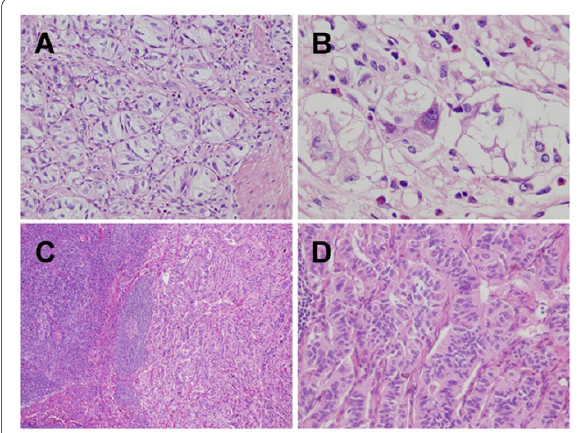
Figure 2 Photomicrographs showing different types of tumor cells . (A) Tumor cells of epithelioid cell type are usually nested which are encompassed by those of spindle-shaped cell type with alignment of a single cell layer (HE double stain, × 400). (B) Ganglion-like cells; third type of the tumor cell had a large and oval nucleus with conspic- uous nucleolus, as well as a polyhedral amphophilic cytoplasm (HE double stain, × 1000). (C and D) The metastasizing component of the tumor at the lymph node comprised the epithelioid cell type alone (HE double stain, × 100, × 400,